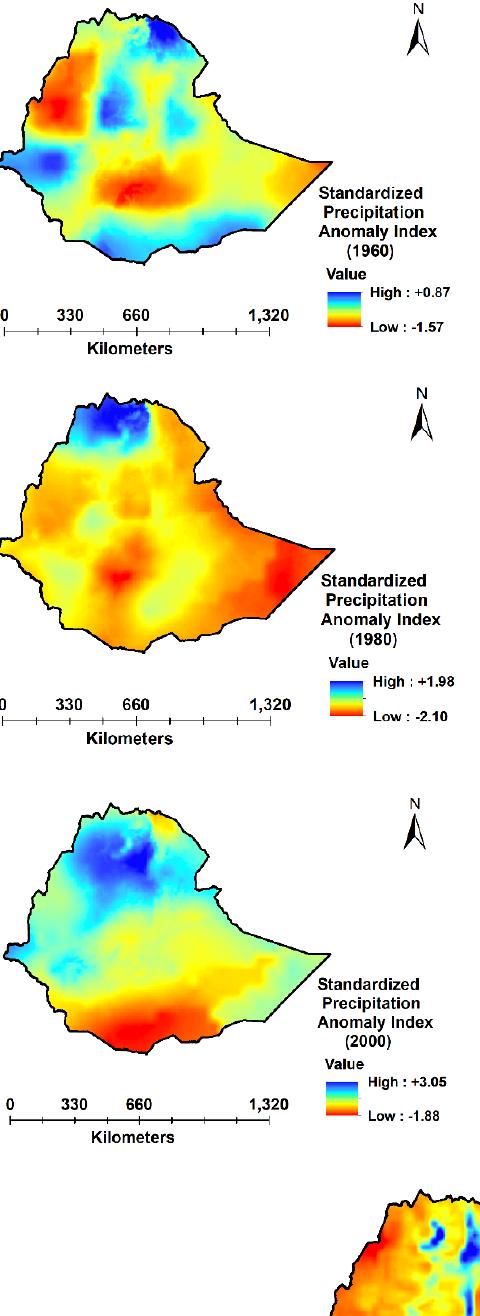
Figure 3. Spatial distribution of the precipitation, maximum and minimum temperature trend (slope of the linear regression) map for 1958–2020 in the study of Ethiopia.